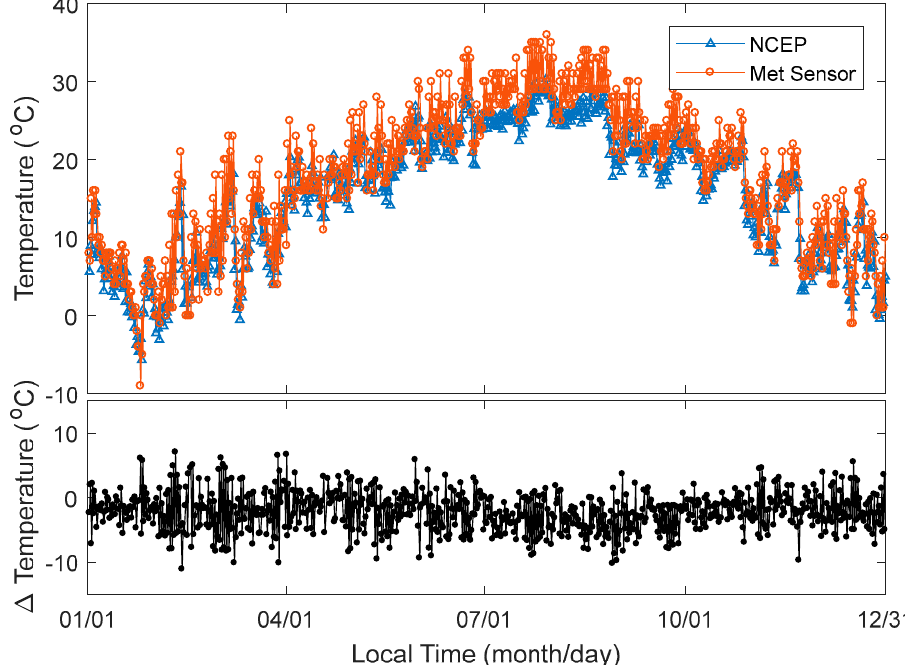
Figure A3. The temperature time series from NCEP and radiosonde at GPS Quzh station and QUZO radiosonde station, respectively.